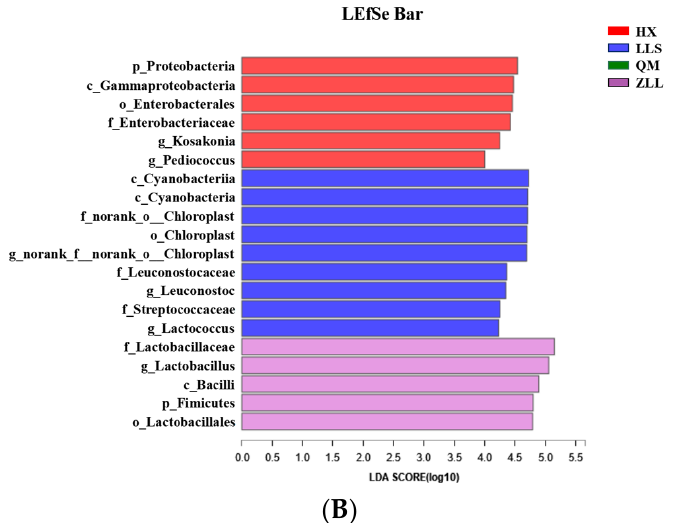
Figure 2. Analysis of biomarkers in sauerkraut. Branching plots ( A ) and histograms of LDA values ( B ) are used for labelling.